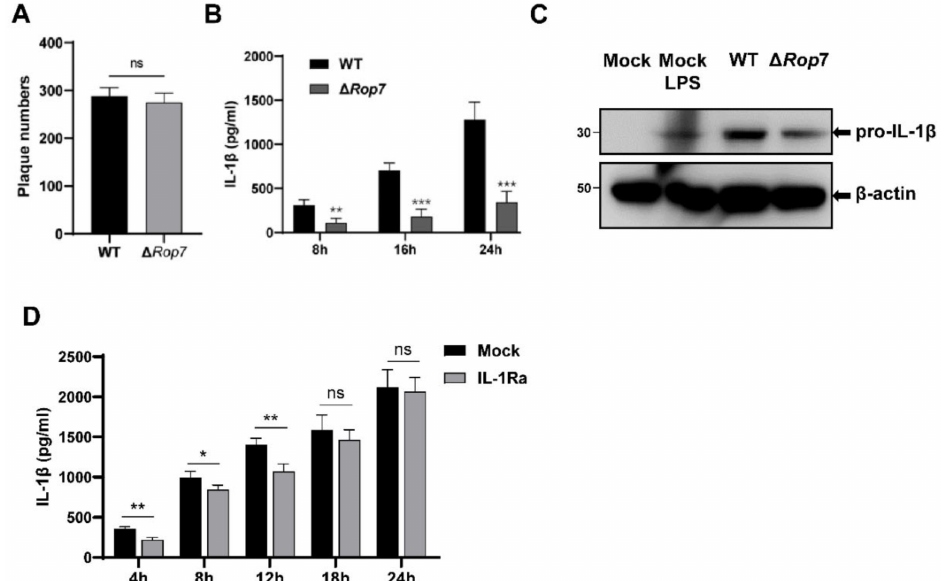
Figure 6. ROP7 knockout in T. gondii reduced parasite-induced IL-1 β secretion in THP-1 cells. ( A ) Plaque assay of WT and ∆ Rop7 strains over 5 days infecting HFF. The plaques were counted using microscope. ( B ) After PMA differentiation, the THP-1 cells were infected with WT or ∆ Rop7 tachyzoites at MOI = 1. Supernatants were harvested at different time, and IL-1 β was detected through ELISA. ( C ) The THP-1 cells were differentiated under 100-nM PMA for 48 h and infected with WT or ∆ Rop7 tachyzoites (MOI = 1). LPS-treated was a positive control. Pro-IL-1 β cleavage was detected by immunoblotting using anti-IL-1 β . ( D ) THP-1 were differentiated under 100-nM PMA for 48 h and treated with 30- µ M IL-1Ra or nothing for 1 h before parasite invasion. The cells were infected with parasites (MOI = 5) with 30- µ M IL-1Ra or none. The IL-1 β in supernatants was detected by ELISA. Data are expressed as mean ± SEM values. ns: non-significant, * p < 0.05, ** p < 0.01, *** p < 0.001, as compared with mock